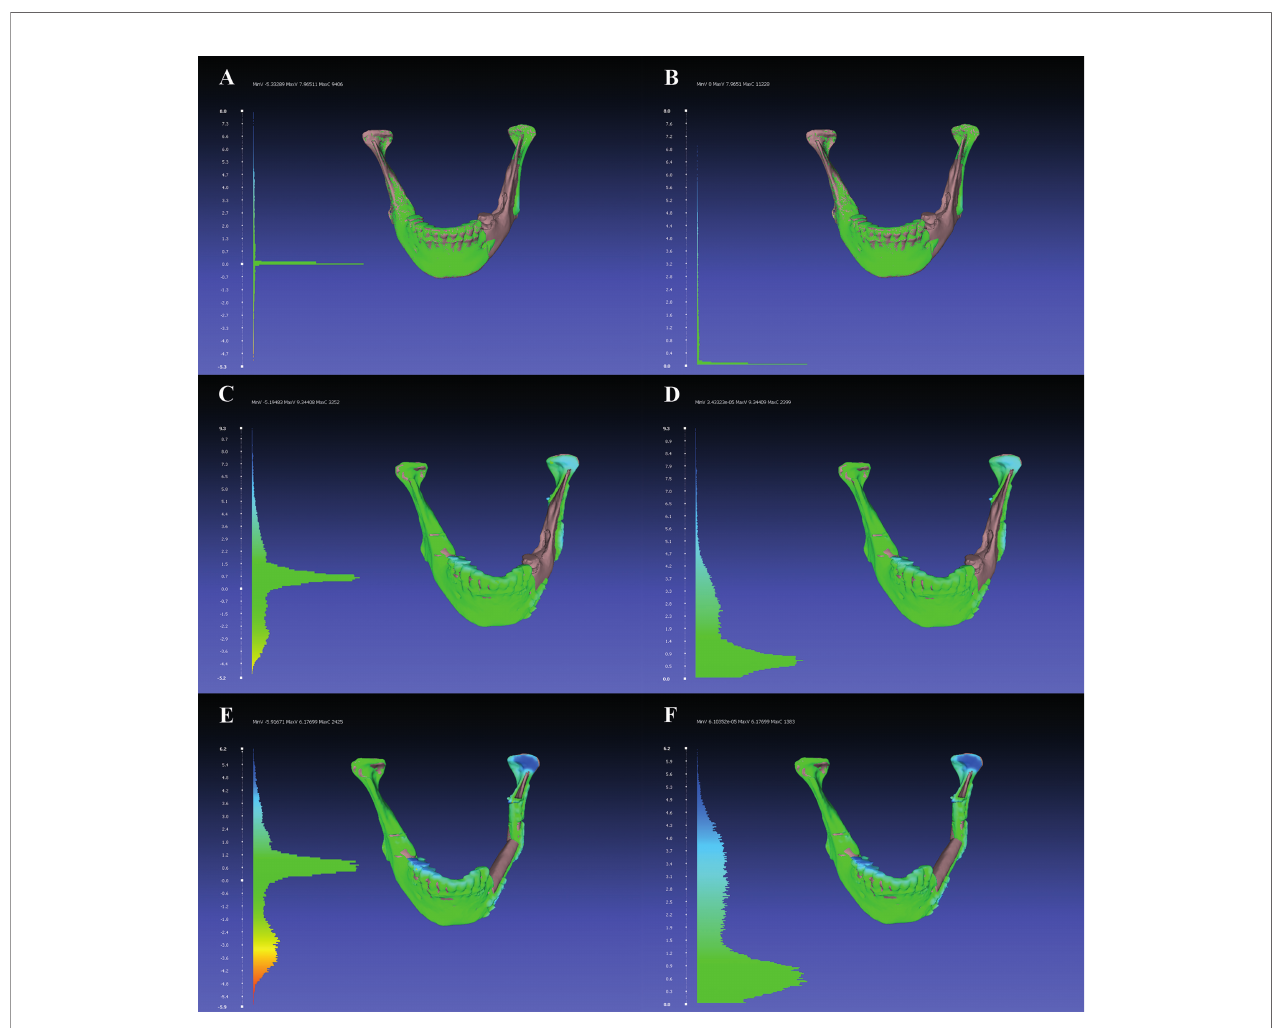
FIGURE 3 | Three-dimensional analyses were done with the open-source software MeshLab (MeshLab_64bit_fp v2020.12) showing root mean square error [RMSE, (mm)] in the left column and Hausdorff distance [HD, (voxel)] in the right column: (A, B) preoperative vs . virtual (pre-virt) model, (C, D) preoperative vs . postoperative (pre-post), and (E, F) virtual model vs . postoperative